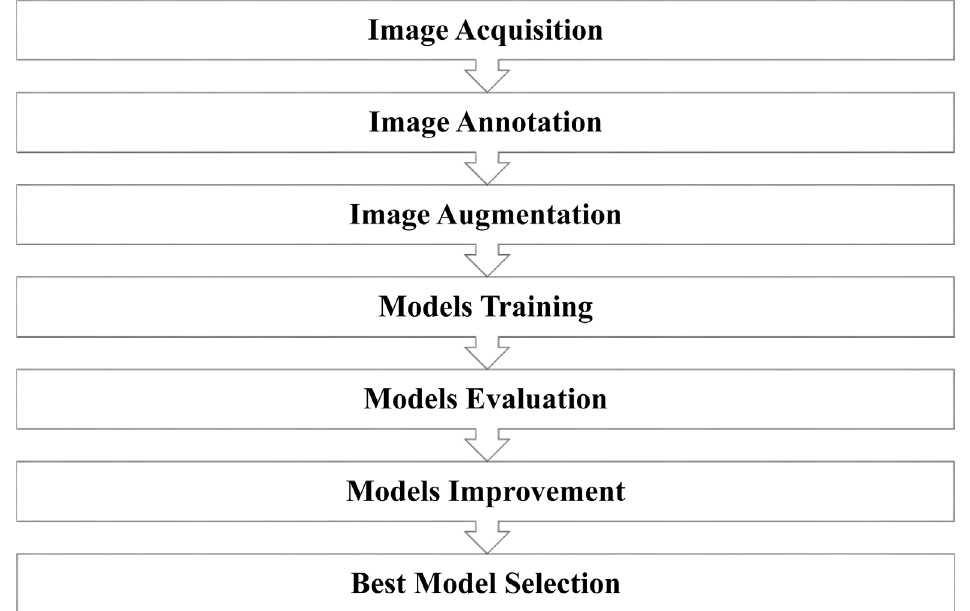
Fig. 1. Flowchart summarizing the design of deep learning